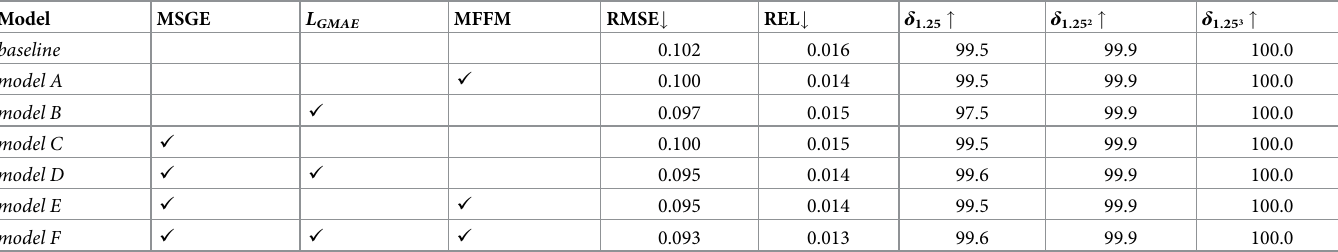
Table 3. The effectiveness of different components.